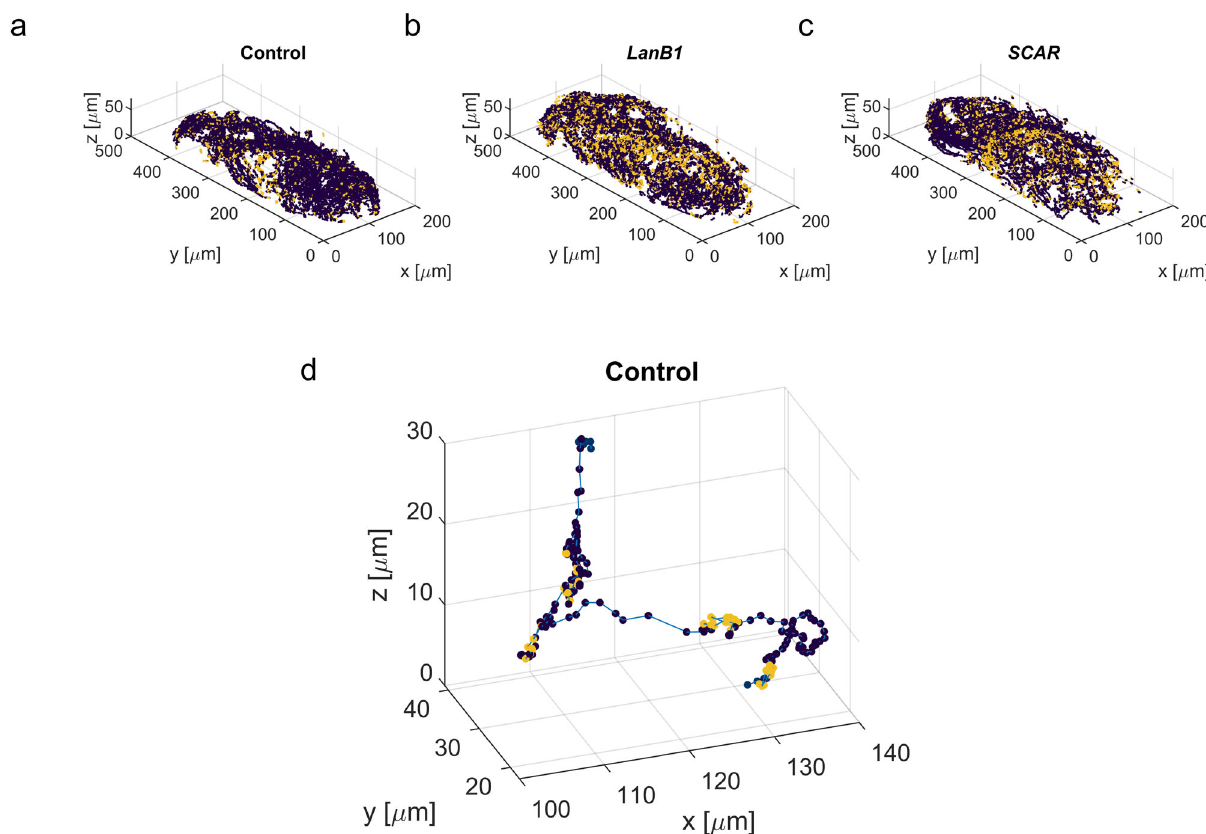
Fig. 1 Hemocytes randomly transition between persistent and anti-persistent motion in different proportions while exploring control and mutant embryos. a – c Three dimensional hemocyte trajectories in one control, LanB1 and SCAR embryo with colours corresponding to local persistent ( H ( t ) > 0.5) (violet) and anti-persistent ( H ( t ) < 0.5) (yellow) motion. Here H ( t ) is the local Hurst exponent estimated using the neural network which describes the roughness of the motion. The Hurst exponent is related to the anomalous exponent of the MSD as H ( t ) = α ( t )/2. LanB1 and SCAR experiments have a greater amount of anti-persistent motion (more yellow) compared to the control. d A single trajectory of a hemocyte cell in the control embryo with colours representing persistent (violet) and anti-persistent (yellow) periods of motion.